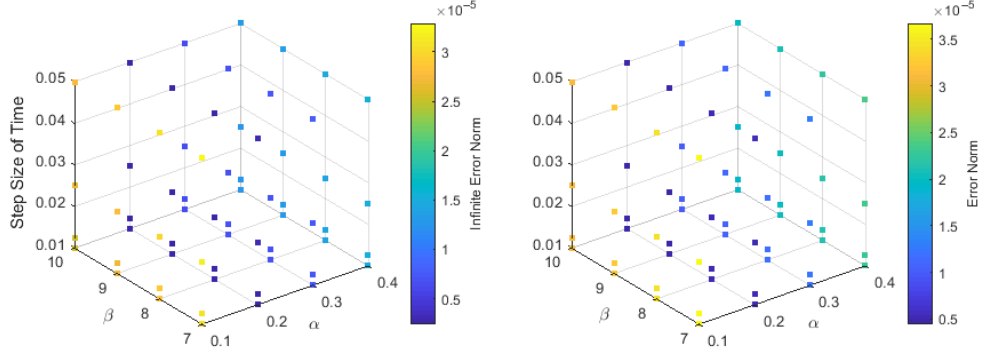
Figure 7. The error functions (cid:107) e n (cid:107) ∞ and (cid:107) e n (cid:107) computed when α equals 0.1, 0.2, 0.3, and 0.4 and β equals 7,8,9, and